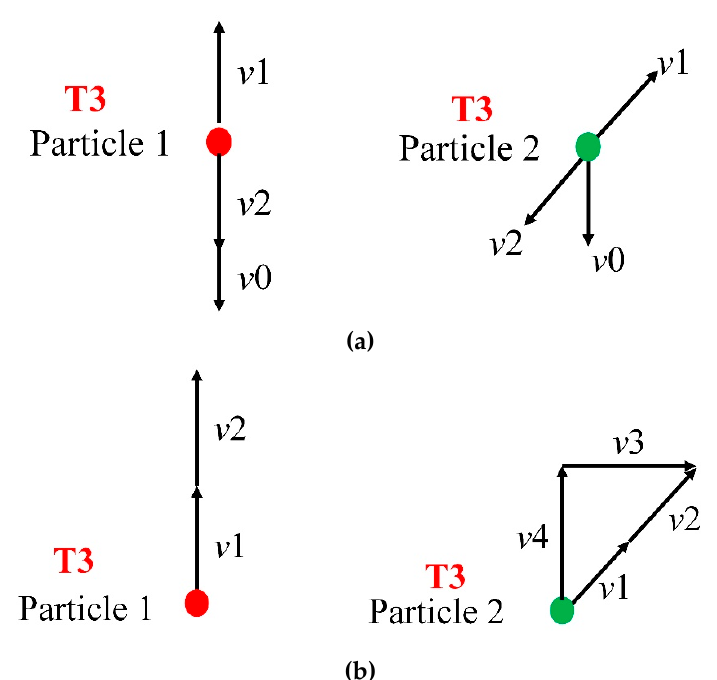
Figure 9. Schematic diagram of particles’ motion at the moment T3, ( a ) the particles near the top with a rigid plate and ( b ) the particles near the top without a rigid plate.